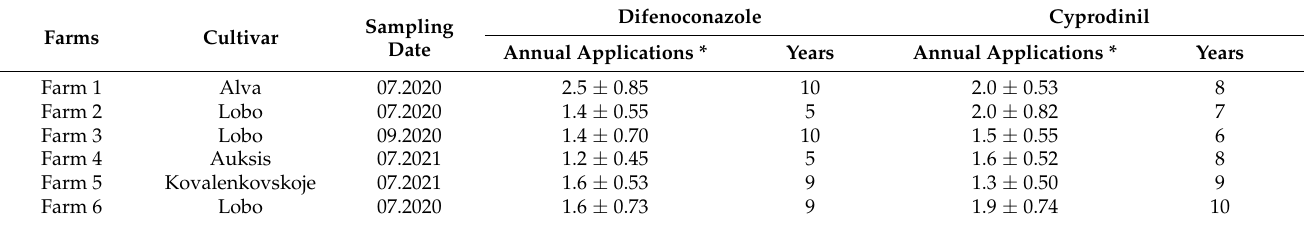
Table 4. The origin and fungicide history of the Venturia inaequalis populations used for the resistance